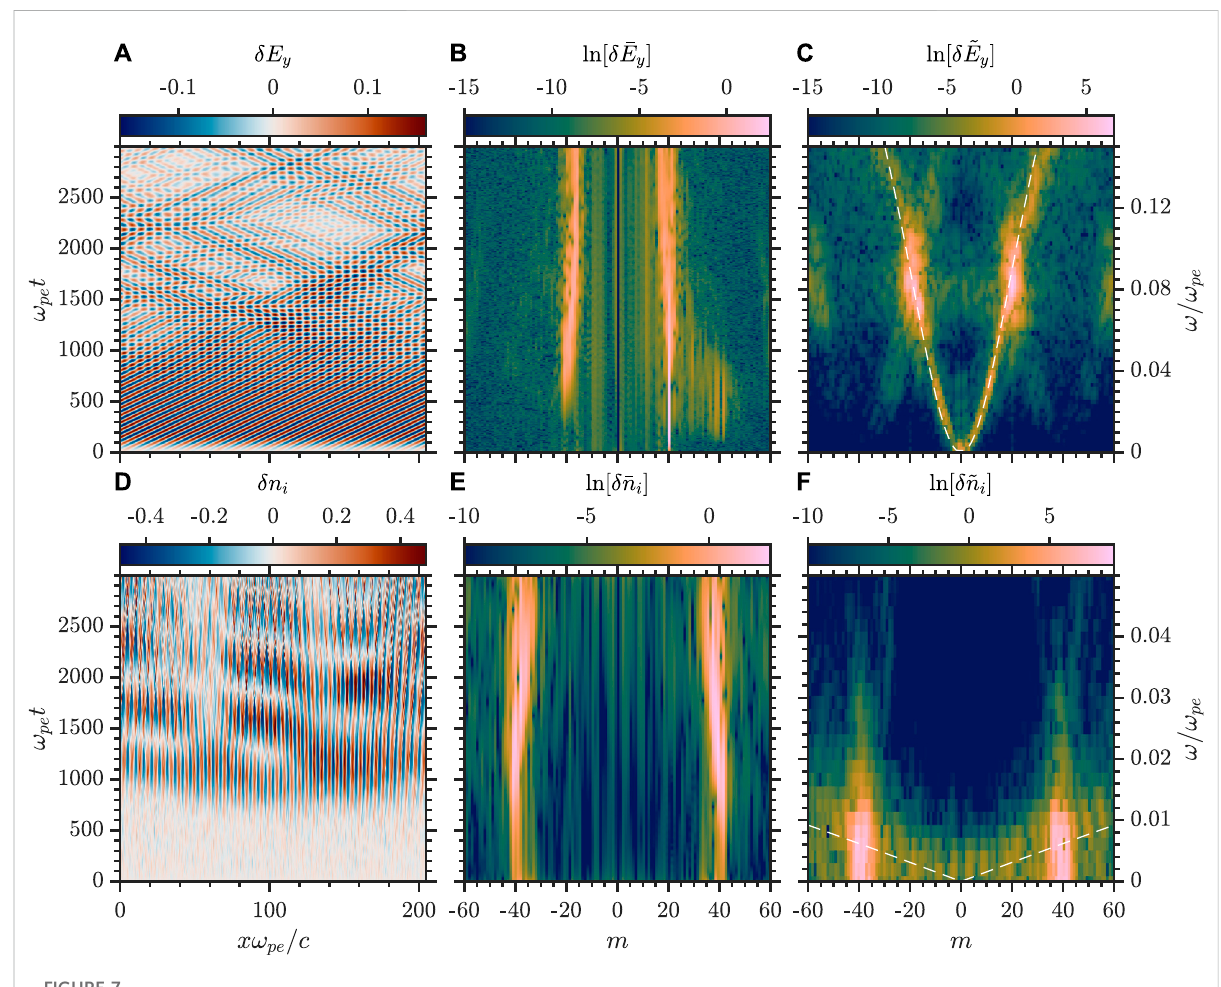
FIGURE 7 Tripleparametricdecayofwhistlerwavewith δ B w / B 0 =0.095withamassratioof M / m e =400 (A) , (B) ,and (C) xt -space, mt -space,and m ω -space of δ E y , respectively (D) , (E) , and (F) xt -space, mt -space, and m ω -space of δ n i , respectively. Dashed lines indicate the whistler and IAW branches in (C) and (F) , respectively, and the solid line is ω ce / ω pe